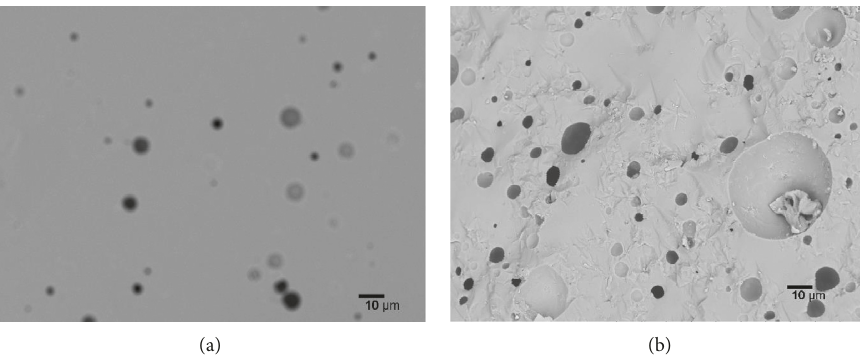
Figure 4: SEM of OGP: (a) Group 2 and (b) Group 3.